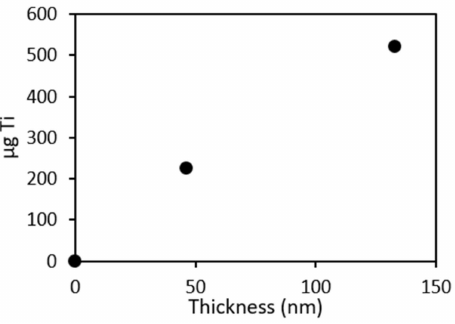
Figure 6. Amount of Ti present in an unstructured TiO 2 film as a function of its thickness.